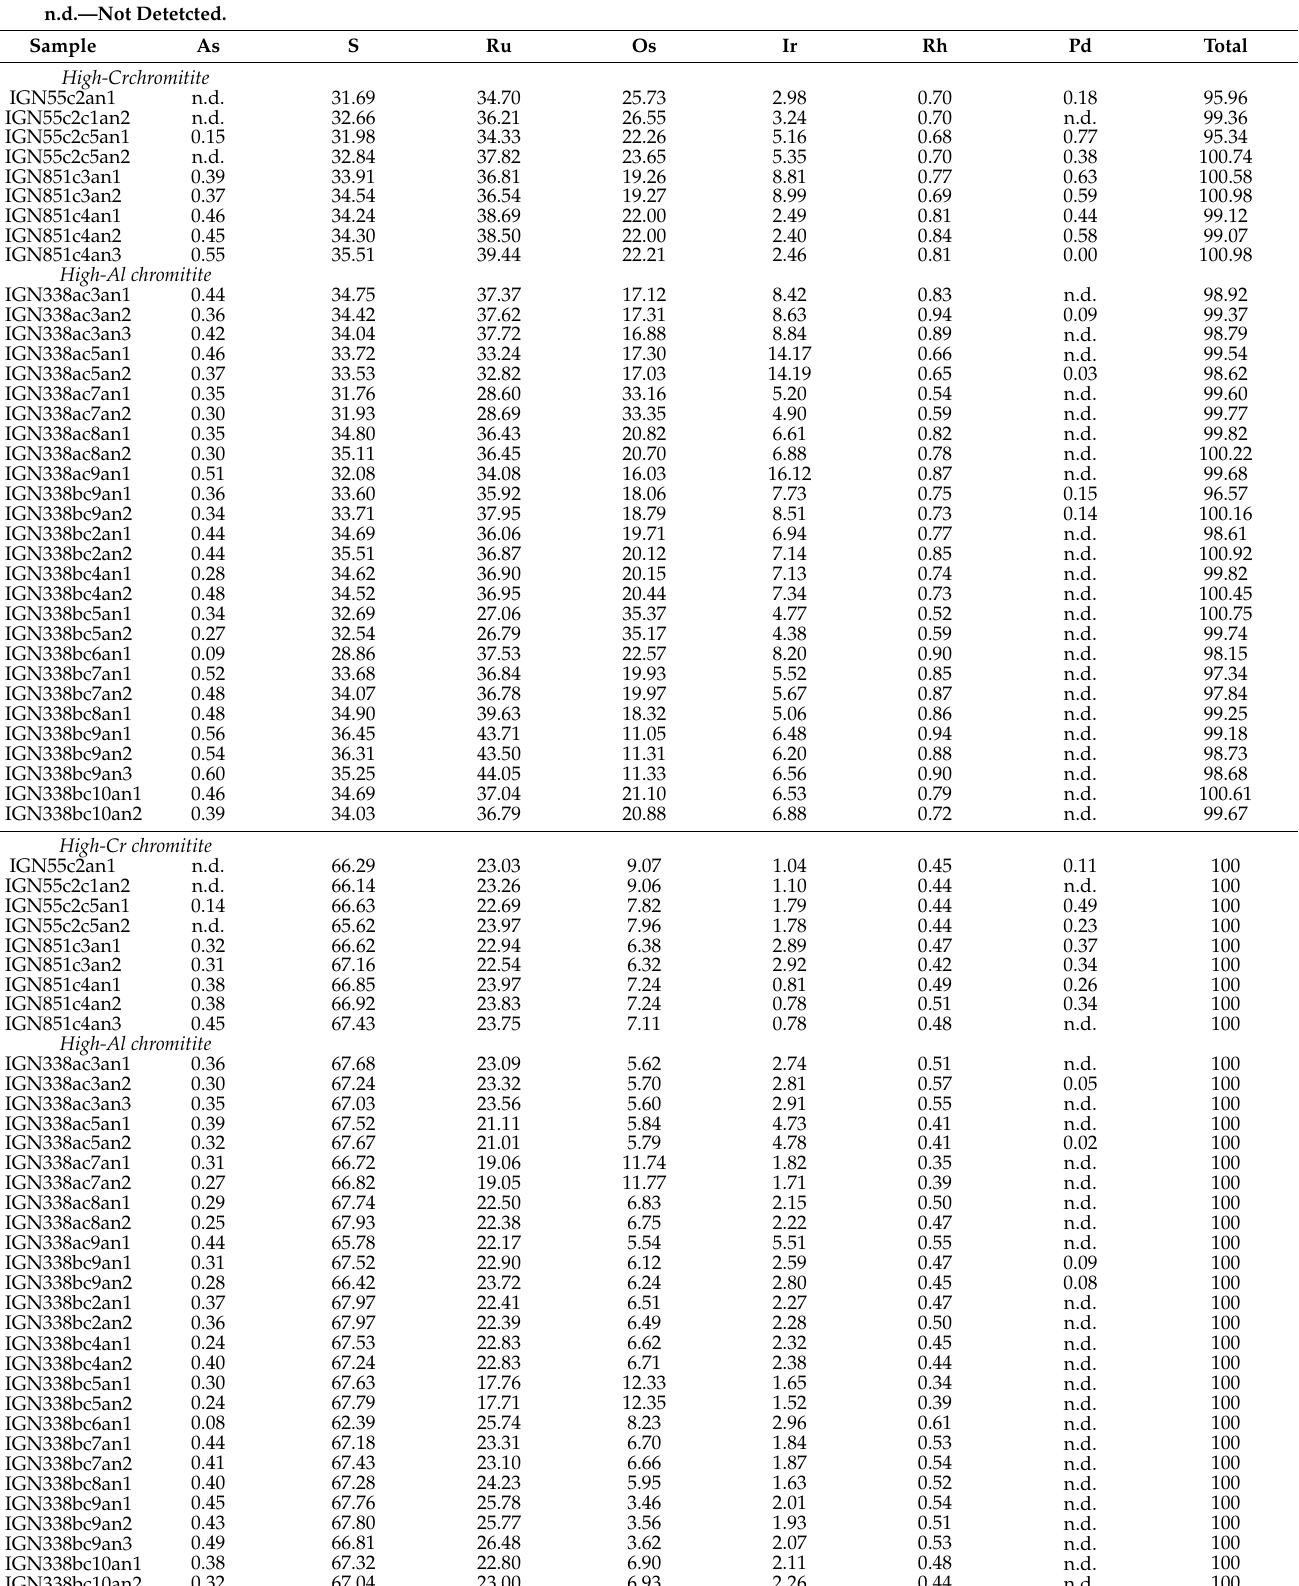
Table 5. Electron microprobe analyses (wt and at%) of laurite from High-Cr and High-Al Chromitite of Sebuku